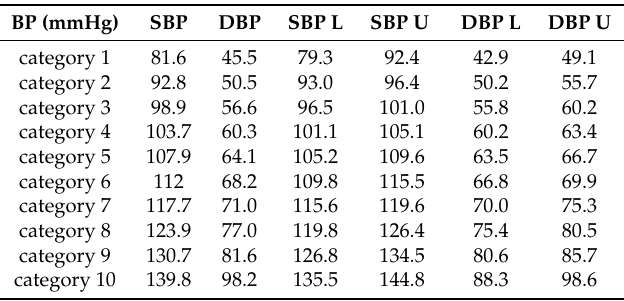
Table 1. BP (blood pressure) categories are represented by the k -medoids algorithm corresponding to cluster locations obtained by nurse BP measurements, where L and U denote lower and upper